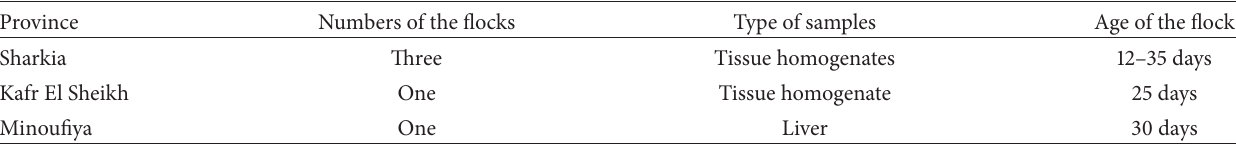
Table 1: Samples collected for the current